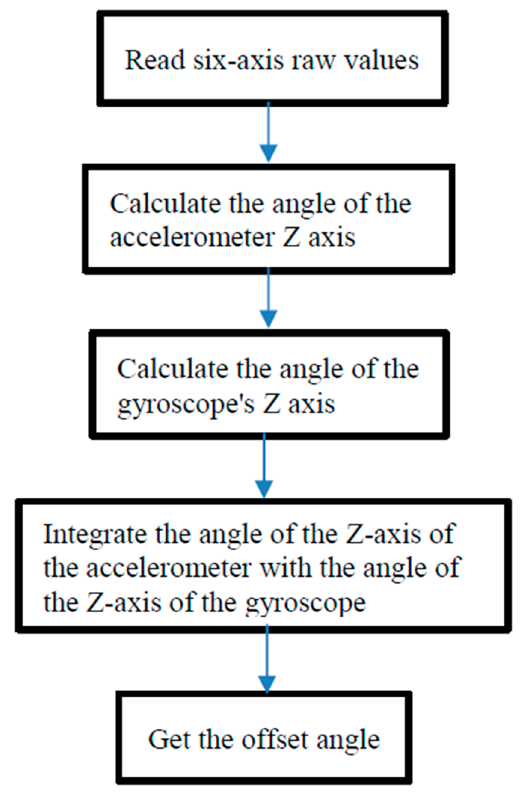
Figure 16. Operation flowchart of six-axis sensors.